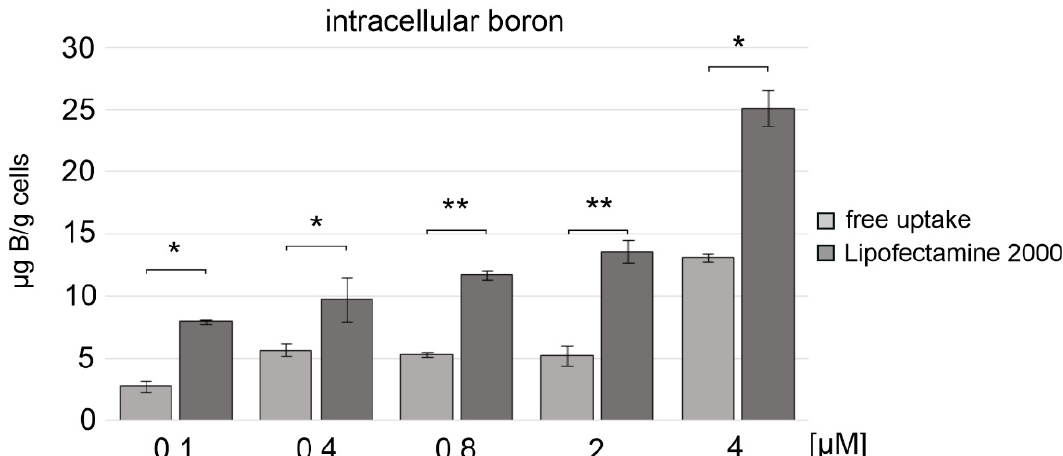
Figure 8. Content of boron atoms in cell lysates of A431 cells transfected with nanostructures 1/2 in the presence of Lipofectamine 2000 or delivered by free uptake (no Lipofectamine 2000 used), as measured by the ICP MS method. Nanostructures 1/2 delivery with Lipofectamine 2000 *** p ≤ 0.001 (ANOVA and post-hoc Tukey HSD test) and without lipofectamine **** p ≤ 0.0001 (ANOVA and post-hoc Tukey HSD test). Comparison of the results of boron delivery by 1/2 with and without Lipofectamine at a given concentration was calculated * p ≤ 0.05, ** p ≤ 0.01 (ANOVA and post-hoc Tukey HSD test).